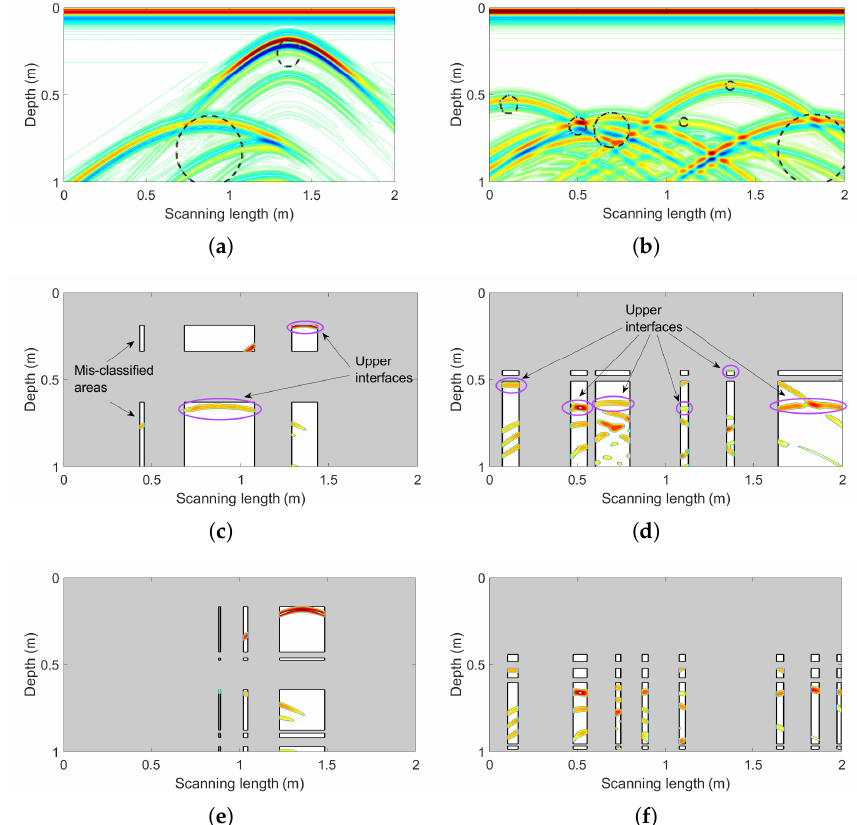
Figure 10. ( a ) The example input profile with two pipelines (central coordinates and diameters ((1.355 m, 0.263 m),0.15 m) and ((0.875 m, 0.823 m), 0.4 m)). ( b ) The example input profile with six pipelines (left five central coordinates and diameters ((0.12 m, 0.56 m), 0.1 m), ((0.505 m, 0.658 m), 0.1 m), ((0.695 m, 0.705 m), 0.2 m), ((1.1 m, 0.66 m), 0.05 m) and ((1.365 m, 0.453 m), 0.05 m), and rightest height and width (0.385 m, 0.37 m)). ( c ) The reconstructed profile of panel (a) by the proposed learning framework. ( d ) The reconstructed profile of panel (b) by the proposed learning framework. ( e ) The reconstructed profile of panel (a) after the independent SVM for comparison. ( f ) The reconstructed profile of panel (b) after the independent SVM for